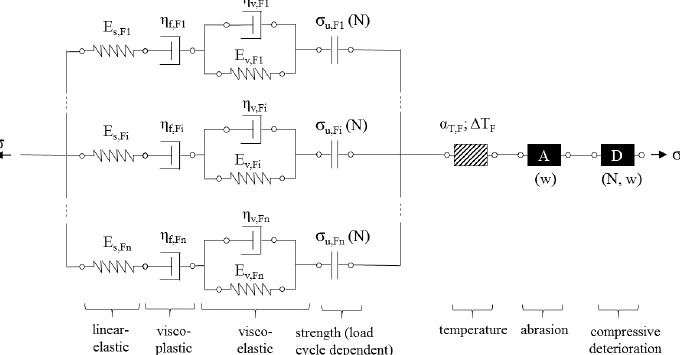
Figure 17. Rheological model of the fibre including the damage mechanism defibrillation.